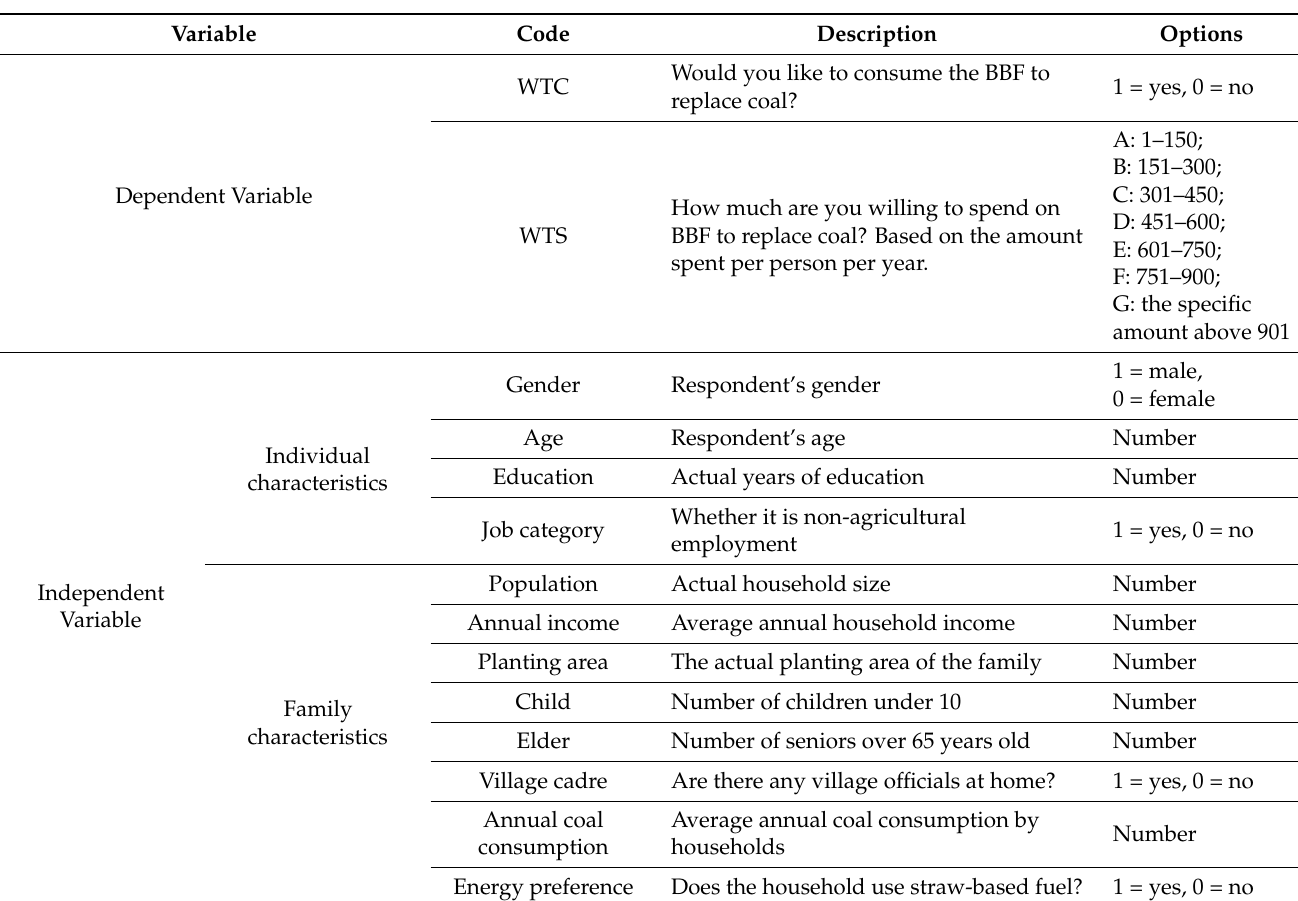
Table 1. The variables’ definition and